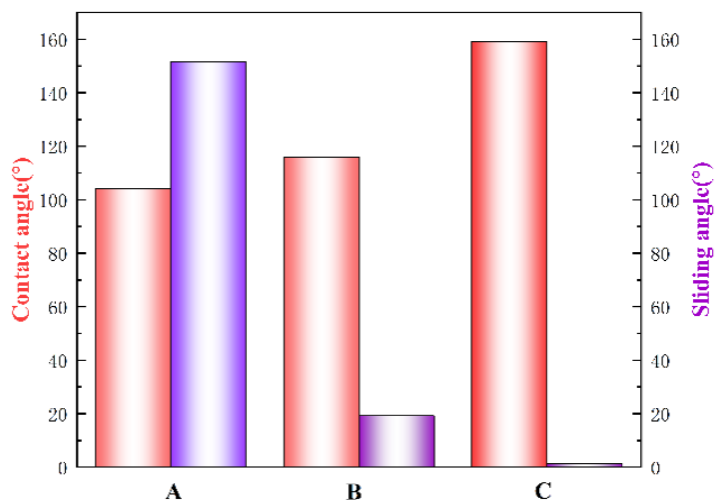
Figure 8. Contact angle and sliding angles of samples A , B, and C ( A — insulator; B — PDMS; C — FAS-17-modified nano-SiO 2 /PDMS).